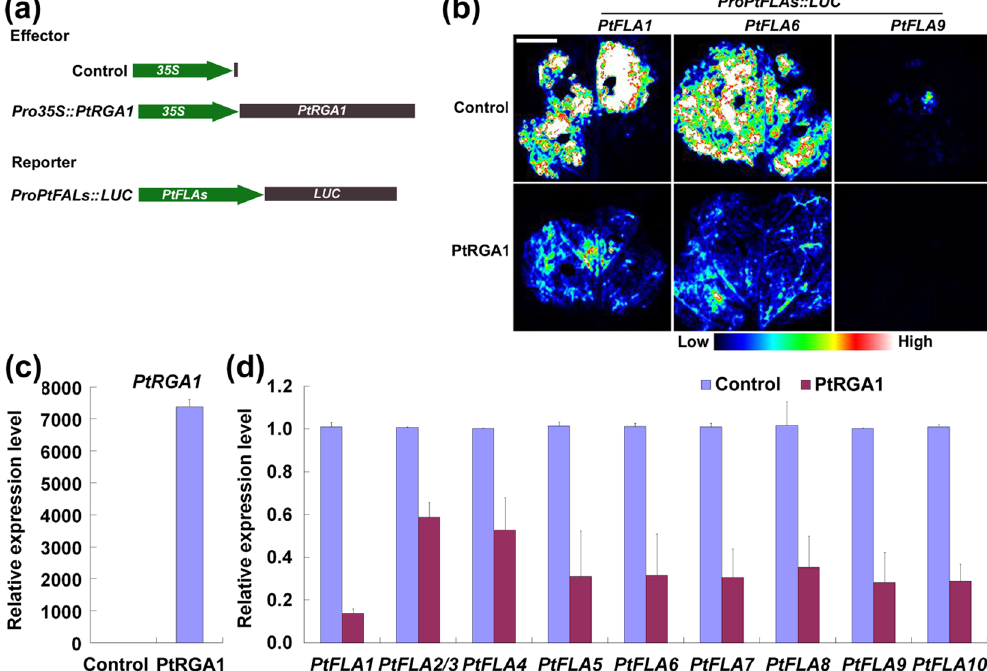
Figure 7. PtRGA1 negatively regulates the expression of PtFLAs . ( a ) Diagrams of effector and reporter constructs for transactivation studies. ( b ) Transactivation assays. Promoter activities of PtFLA1 , PtFLA6 and PtFLA9 were obviously repressed in N . benthamiana leaves infiltrated with the construct combinations of Pro35S::PtRGA1 and each ProPtFLA::LUC . Bars = 1 cm. ( c , d ) Expression analysis of PtFLA s in the poplar xylem protoplasts overexpressing PtRGA1 . RNA was extracted from the poplar xylem protoplasts transfected with pGreenII62-SK- PtRGA1 . Then qRT-PCR was performed to analyze the transcriptional levels of PtRGA1 ( c ) and PtFLA s ( d ). Gene expression level in control was set to 1. Error bars represent the SDs from three biological replicates. Control, protoplasts transfected with pGreenII62-SK; PtRGA1, protoplasts transfacted with pGreenII62-SK- PtRGA1